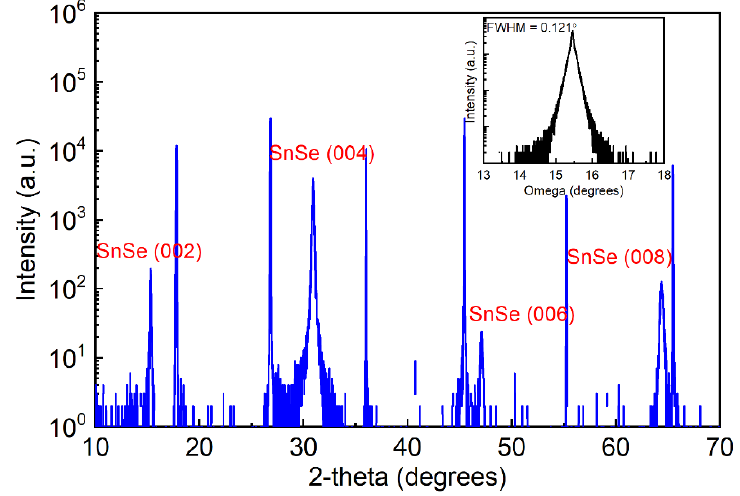
Figure 2. X-ray diffraction θ –2 θ scan probing the out-of-plane orientation of the SnSe film on a mica substrate. The inset shows the rocking curve conducted on the SnSe (004) plane.